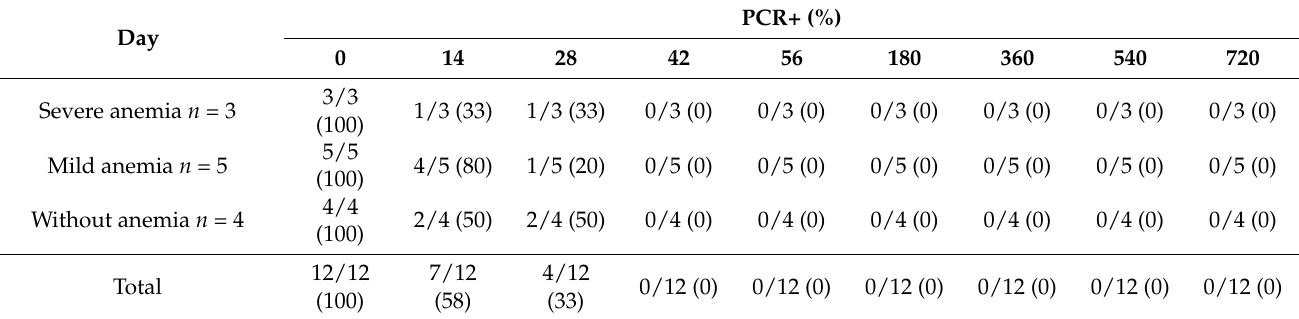
Table 2. Results of polymerase chain reaction (PCR) testing for Babesia gibsoni in 12 dogs following the treatment with Malarone ® , azithromycin and artesunate combination, divided into groups according to anemia